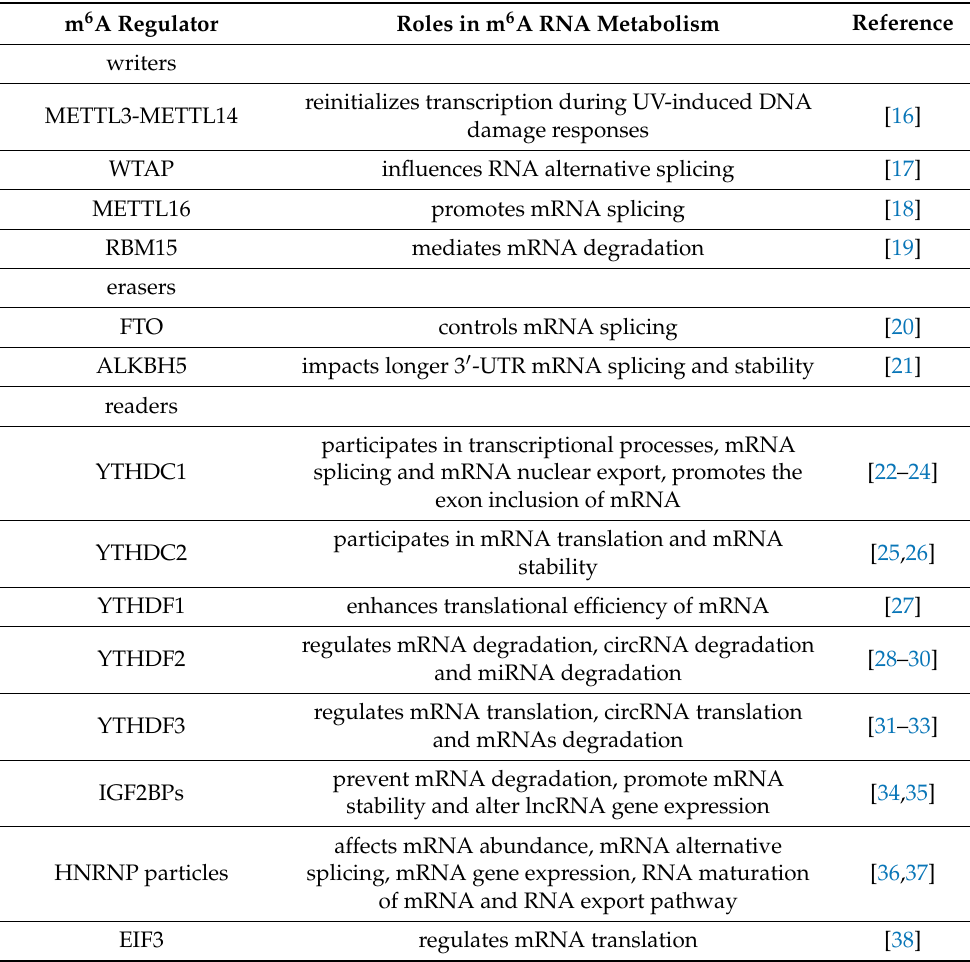
Table 1. Roles of m 6 A regulators in m 6 A RNA